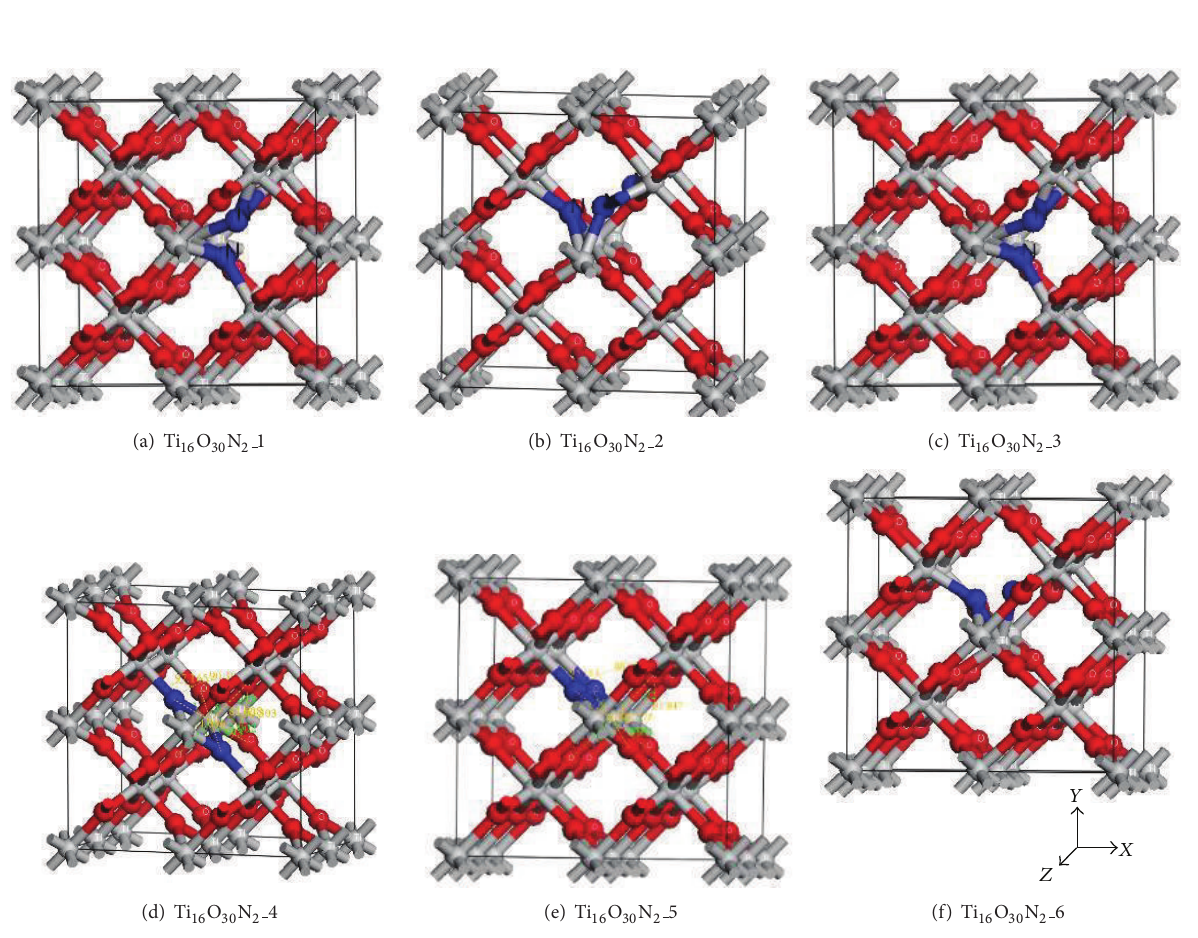
Figure 4: The structures of six kinds of Ti 16 O 30 N 2